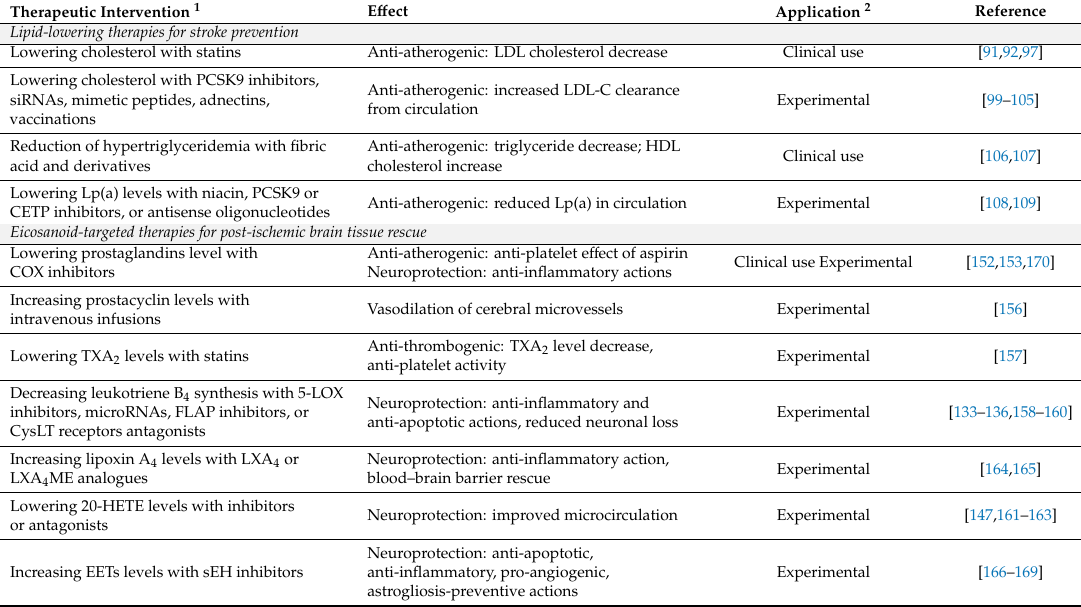
Table 1. Therapeutic interventions targeting lipids and lipid mediators in the prevention and treatment of ischemic